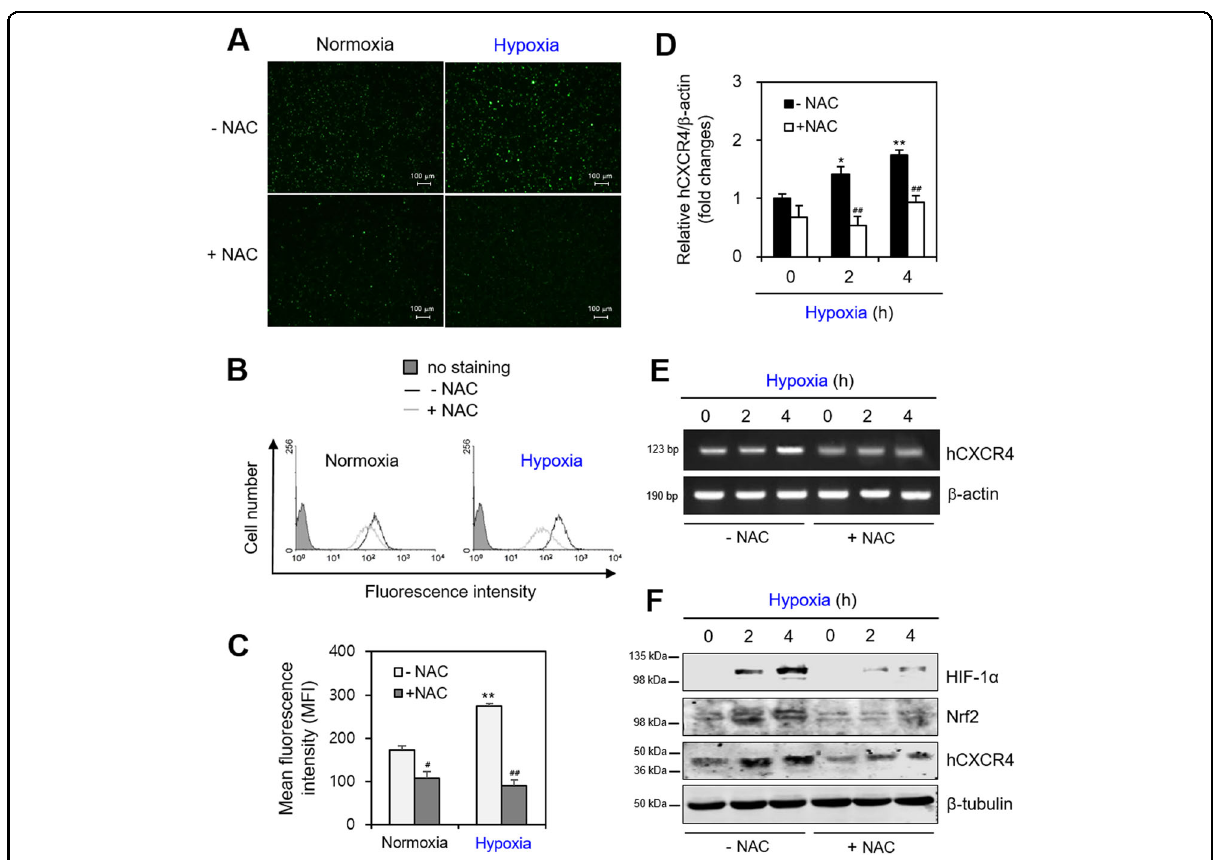
Fig. 3 CXCR4 expression was inhibited by the treatment with N-acetyl- L -cysteine (NAC). A – F WiL2-NS cells were incubated in the presence or absence of N-acetyl- L -cysteine (NAC) under hypoxic condition and treated with DCF – DA. ROS production was observed under fl uorescence microscope ( A ) or it was measured by fl ow cytometry analysis ( B ). The mean fl uorescence intensity (MFI) was analyzed by WinMDI 2.8 for ROS level and represented as bar graph ( C ). RNA was extracted by using Nucleozol. mRNA of hCXCR4 was measured by qPCR ( D ) or RT-PCR ( E ). Cell lysates were prepared and the protein level of each protein was measured by using western blot analysis ( F ). Each experiment was performed at least fi ve times. Data in a bar graph represented the means ± SD. * p < 0.05, ** p < 0.01; signi fi cantly different from control group under normoxic condition. # p < 0.05, ## p < 0.01; signi fi cantly different from NAC-untreated group ( C , D